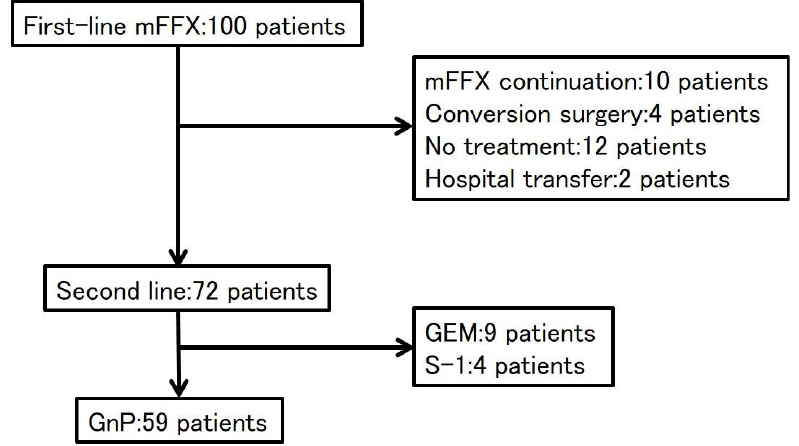
Figure 1. Consort diagram. mFFX: modified FOLFIRINOX, GEM: gemcitabine, GnP: gemcitabine plus nab-paclitaxel. Table 1. Demographics and baseline characteristics of patients in the PN and non-PN group at the start of